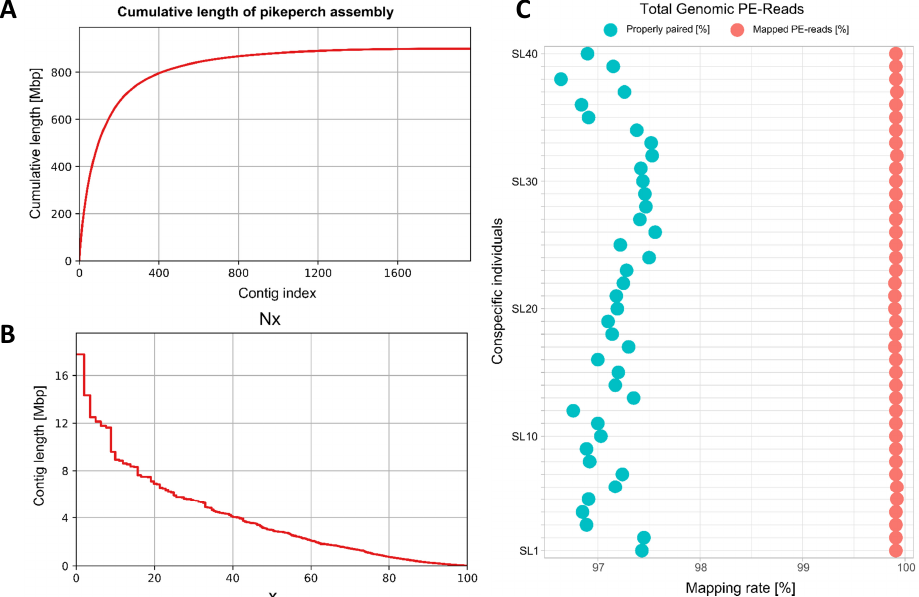
Figure 3. Assembly length and mappability statistics. ( A ): The cumulative length of pikeperch assembly in correlation with the total number of contigs, sorted from the largest to the shortest. ( B ): Overall trend of contigs Nx-metric as x varies from 0 to 100. ( C ): Mapping rates of genomic paired-end reads of 40 pikeperch individuals to our constructed reference pikeperch assembly.